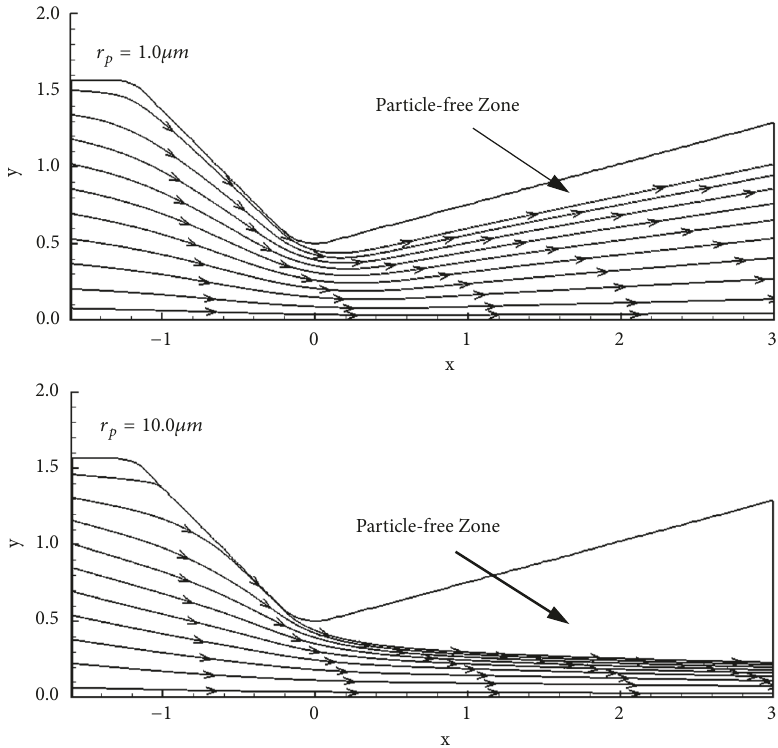
Figure 9: Particle trajectory in the